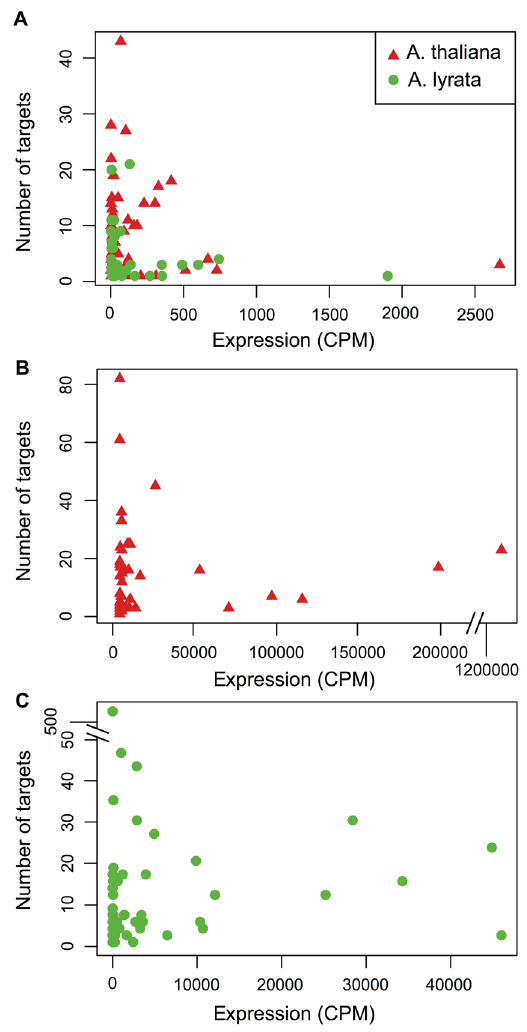
for each miRNA in A. thaliana (red) and A. lyrata (green). ( A ) Species-specific miRNAs in both Arabidopsis species. ( B ) Conserved miRNAs in A. thaliana . ( C ) Conserved miRNAs in A. lyrata